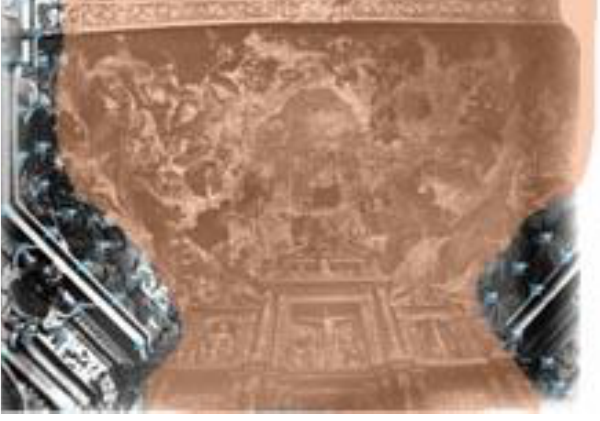
Figure 12. Complete image over the vault.